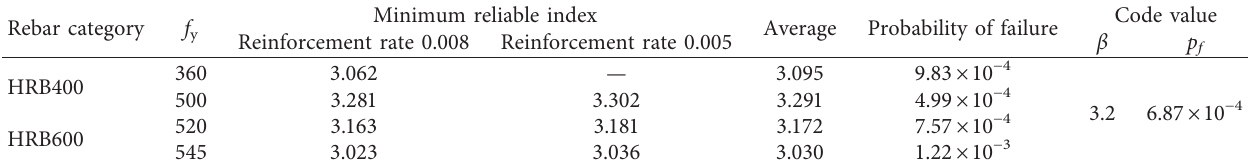
Table 12: The minimum reliable indexes and failure probability of the C60 test beam under different conditions.